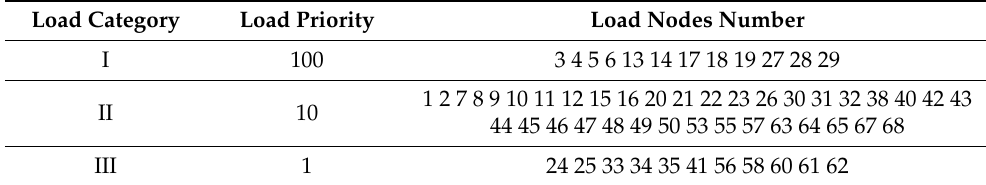
Table A1. Load priority of each load point in PG&E 69-bus system. Load